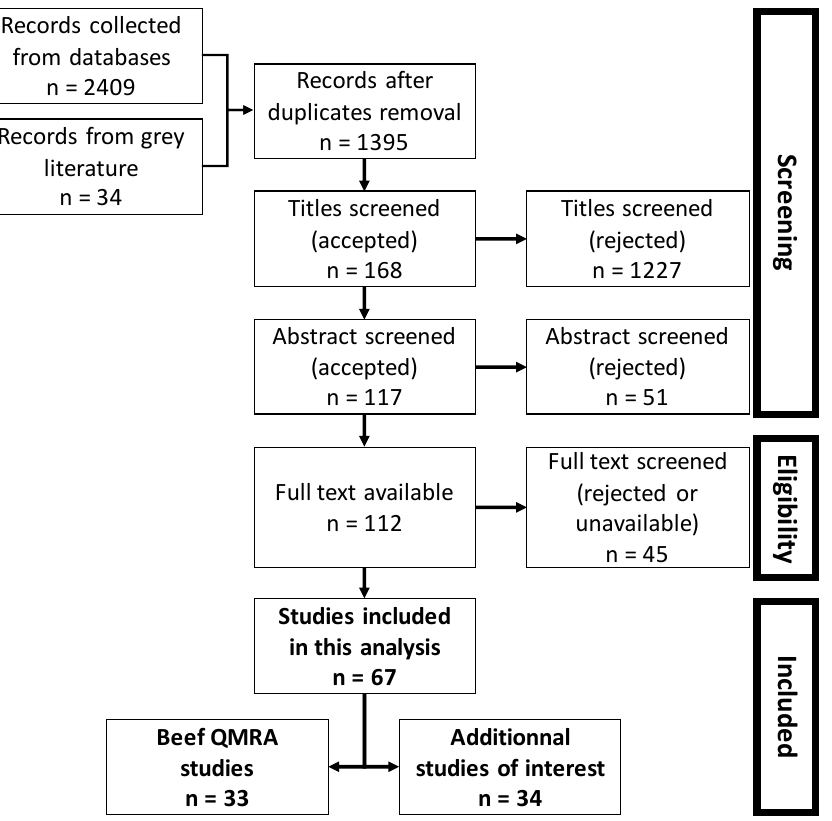
Figure 1. Flow chart of studies selected using Preferred Reporting Items for Systematic Reviews and Meta-Analyses (PRISMA) method. QMRA: Quantitative Microbial Risk Assessment.